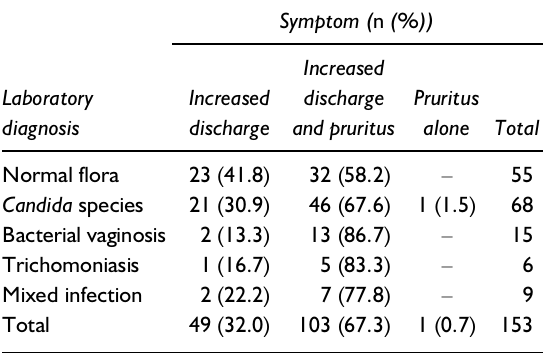
Table 4 Correlation of symptoms with laboratory diagnosis; p £ 0.1; numbers in parentheses are